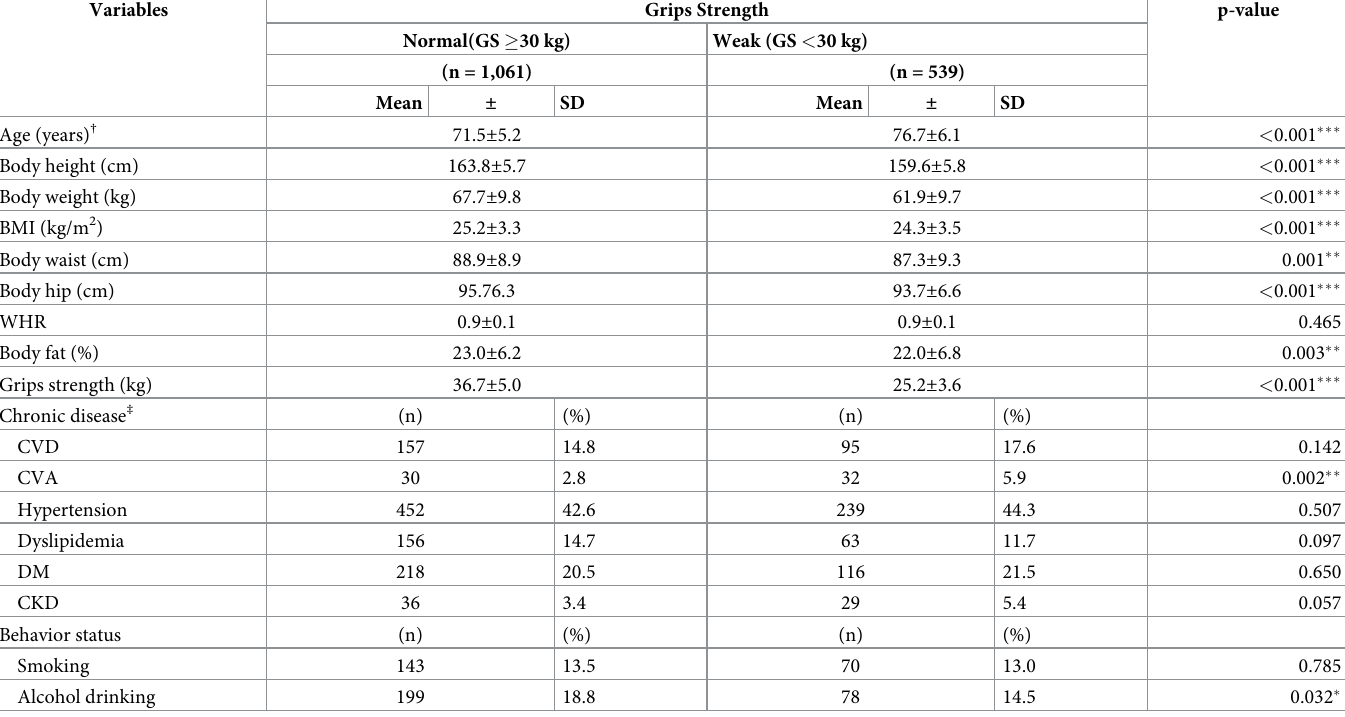
Table 1. General characteristics and grip strength among male elderly population (n = 1,600).